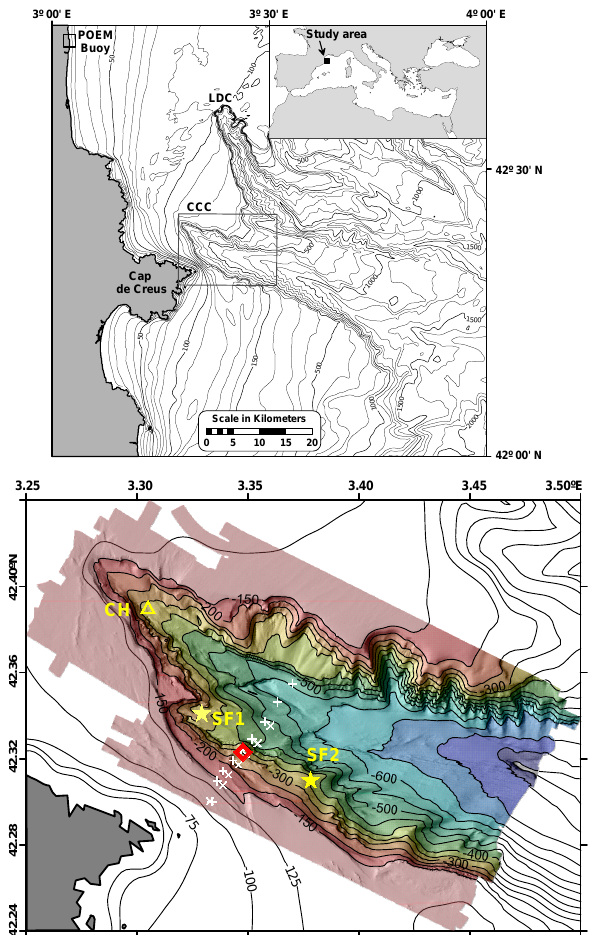
Fig. 1. (a) Bathymetric chart of the western Gulf of Lion show- ing the main submarine canyons in this area, the Lacaze-Duthiers (LDC) and Cap de Creus Canyon (CCC). The position of the POEM coastal site is also shown; (b) multibeam bathymetry of the CCC provided by Fugro Survey Ltd. and AOA Geophysics Inc. Stars mark the location of two temporary instrumented lines (SF1 and SF2) maintained in the southern canyon flank from 3 to 21 March 2011. The triangle marks the location of a long-term mooring line in the canyon head (CH). The position of a high-resolution CTD station “CX” (11–14 March) is marked with a red diamond. White crosses represent CTD casts’ positions during two cross-canyon hy- drological transects conducted on 14 and 21 March, the longest one corresponding to 14